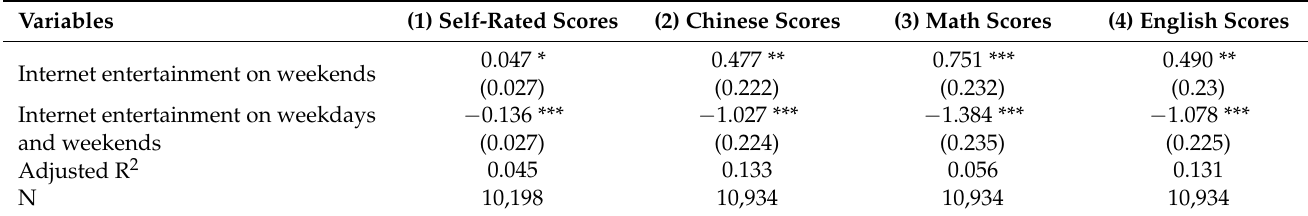
Table 5. Influence of internet entertainment on academic performance.